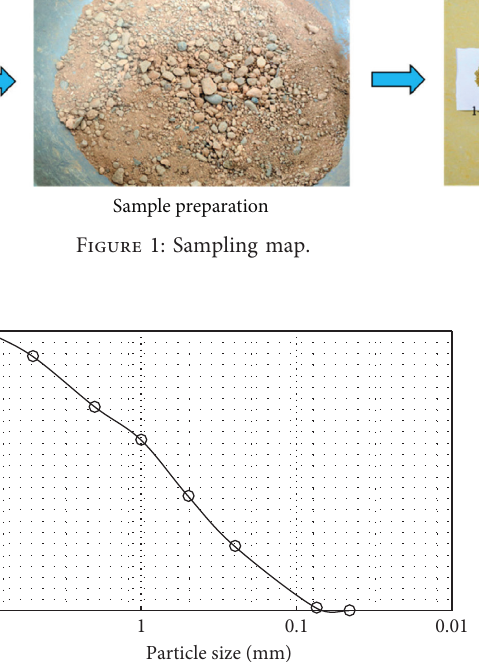
Figure 2: Grain-size distribution of the gravelly sand sample.